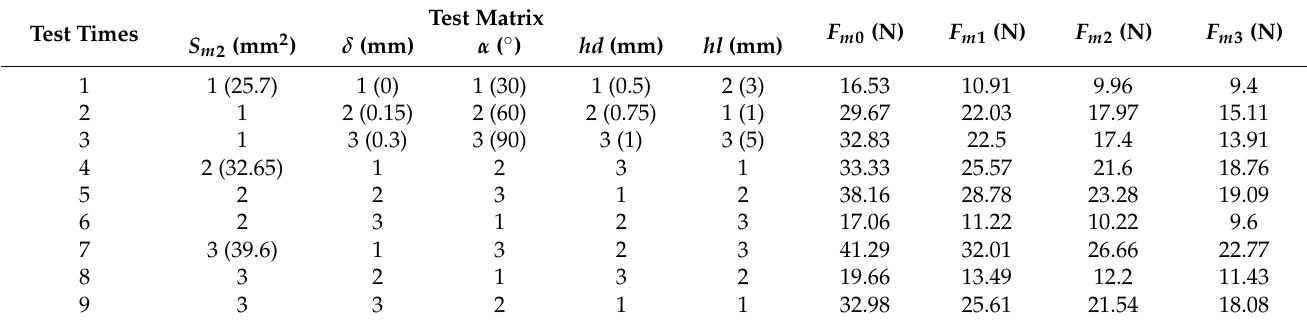
Table 5. Test matrix and finite element analysis